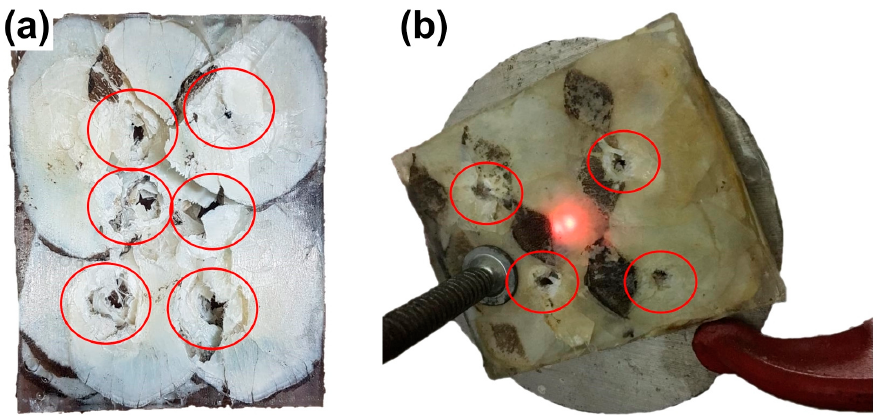
Figure 10. Stand-alone test samples after ballistic impact: ( a ) tested with 0.22 caliber and ( b ) 7.62 mm caliber ammunitions, in which the perforation damage after the multiple shots is highlighted by the red circles .